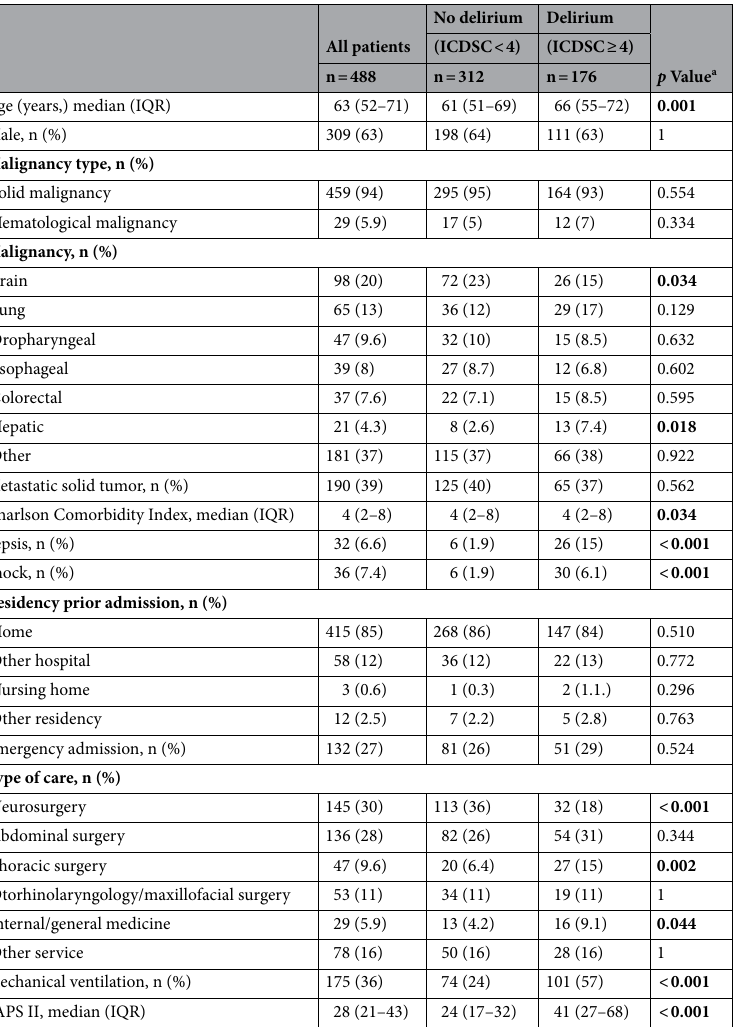
Table 1. Patient characteristics: Comparison between delirious and non-delirious patients with malignancy. ICDSC intensive care delirium screening checklist, IQR interquartile range, SAPS II simplified acute physiology score II. a Comparison of the groups delirium versus no delirium by Fisher’s exact or Mann–Whitney U tets. Bold indicates